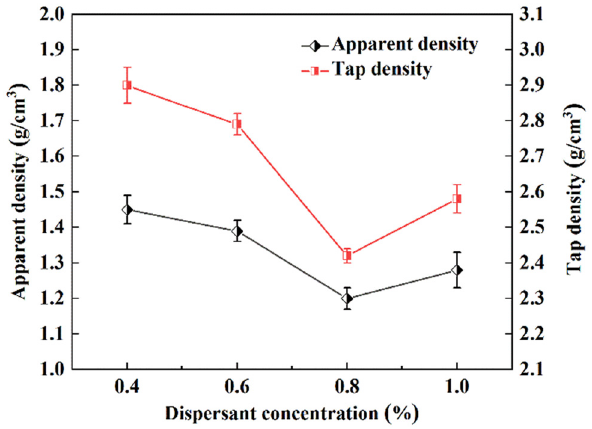
Figure 5: Apparent density and tap density of silver powder prepared with di ff erent dispersant